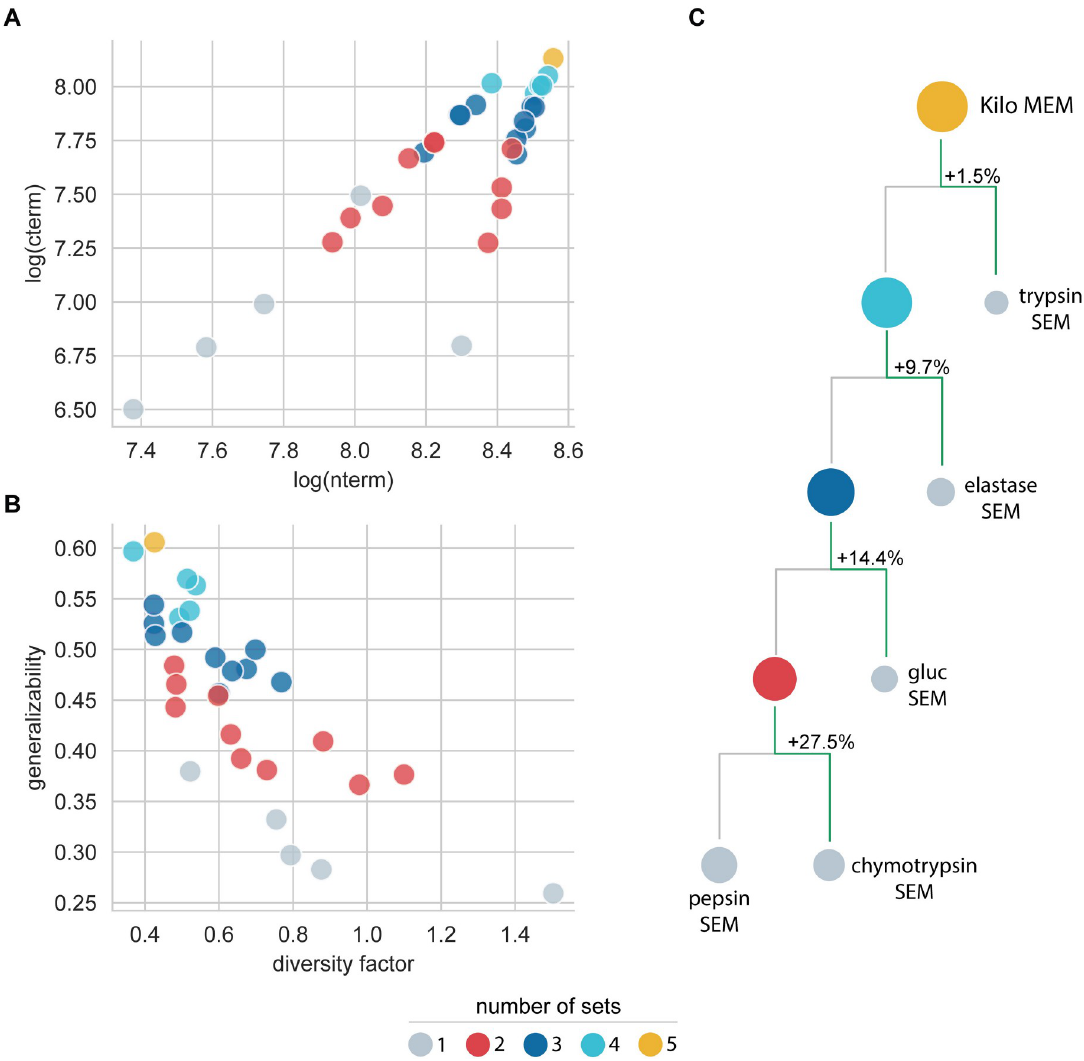
Fig 4. Characteristics and performance of multienzyme (MEM) models. A. Training sets’ Tn and Tc values; B. MEMs’ generalizability vs. diversity factor; C. Sequential building of Kilo MEM from all five SEM datasets. The size of circles is proportional to their generalizability values on the Detroit test set. The color scheme at the bottom reflects the models’ characteristics variation with the number of combined datasets. SEM data (displayed in gray) were used as reference.